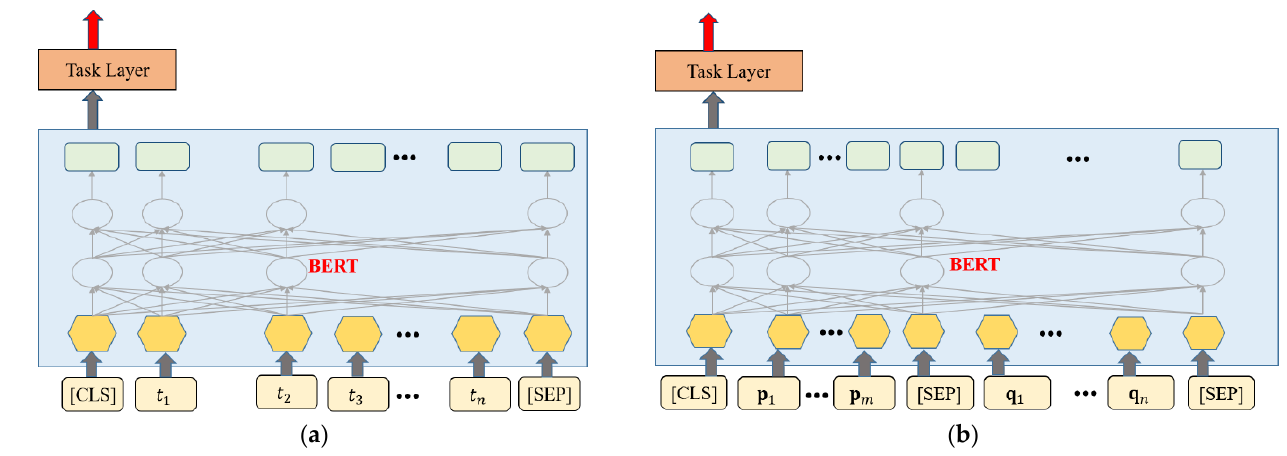
Figure 2. An illustration of typical BERT-based text classification models. ( a ) BERT-based model for single text classification, which takes a single sequence of tokens as input. ( b ) BERT-based model for text-pair classification, which converts two input sequences of tokens into one by inserting a separator token [SEP] between them. Experiments presented in this article adopt one of these two models according to the input format.